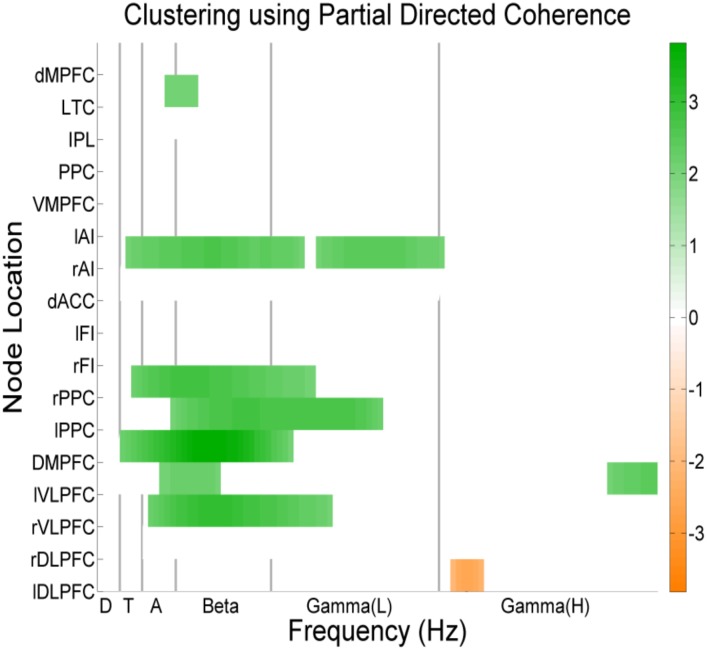
Non-aggregated nodal network connectivity.Clustering coefficient of PDC values in nodal analysis for beta band for patients (green) and controls (orange).